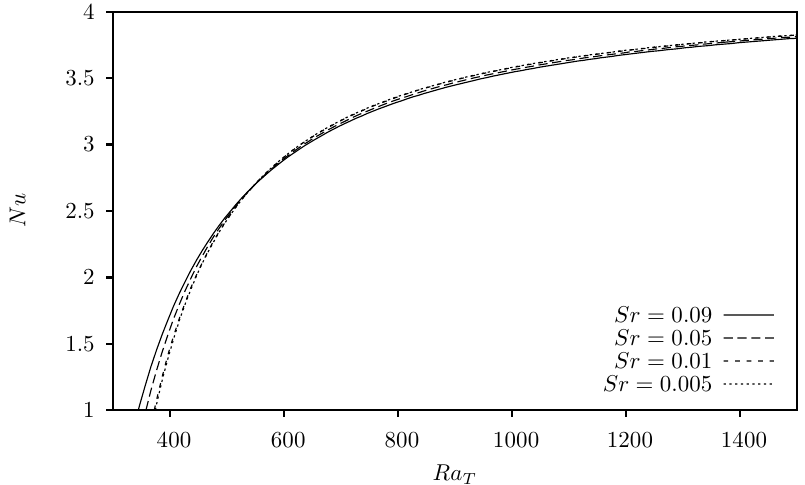
Figure 10. Variation of Nu with Ra T for steady nonlinear stability: effect of Sr for Du = 0.05, Ra s = 250, Ri = 1, Le = 1.